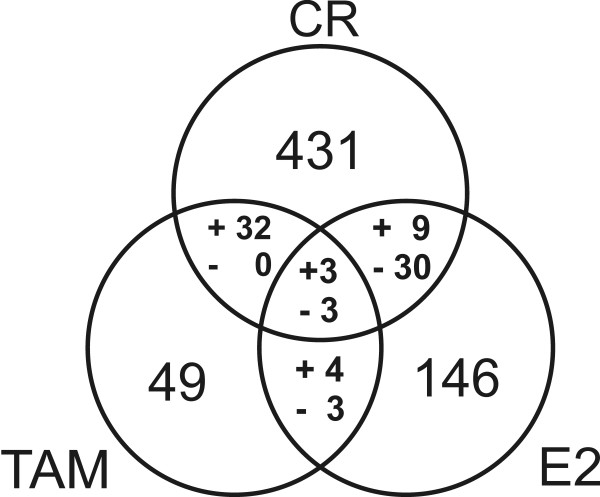
Overlap of expression profiles. Numbers within the 3 circles represent the genes that were differentially expressed according to our filters after 24 h treatment of MCF-7 cells with Cimicifuga racemosa (black cohosh) extract (CR), 17β-estradiol (E2) or tamoxifen (TAM). Numbers within the intersections represent genes regulated with both of the respective treatments or – in the middle – all 3 different treatments. For every intersection genes regulated in the same direction up or down (correlated) are marked with (+). Genes regulated in opposite directions (anti-correlated) are marked with (-).